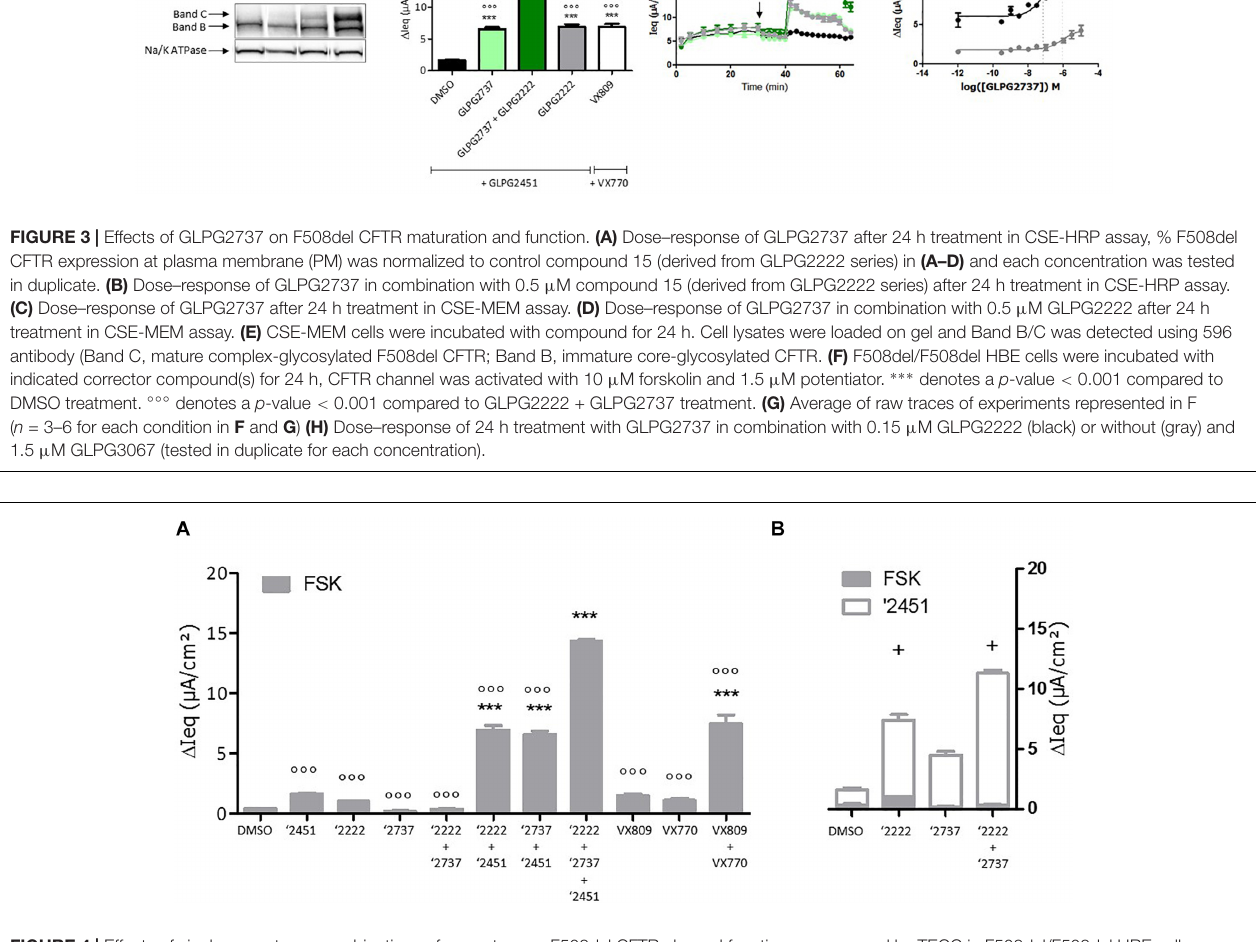
FIGURE 4 | Effects of single corrector or combinations of correctors on F508del CFTR channel function as measured by TECC in F508del/F508del HBE cells. (A) Compounds (0.15 µ M GLPG2222 and/or 1 µ M GLPG2737 and/or 1.5 µ M GLPG2451) were incubated on cells for 24 h, CFTR channel was activated with 10 µ M forskolin and change in short circuit current was measured in three to six replicates for each condition ∗∗∗ denotes a p -value < 0.001 compared to DMSO treatment. ◦◦◦ denotes a p -value < 0.001 compared to GLPG2222 + GLPG2737 + GLPG2451 treatment. (B) Compounds (0.15 µ M GLPG2222 and/or 1 µ M GLPG2737) were incubated on cells for 24 h, CFTR channel was activated with 10 µ M forskolin followed by 1.5 µ M potentiator GLPG2451 and change in short circuit current was measured after forskolin activation and after GLPG2451 addition. n = 3 for each condition and p -values are denoted with + meaning p < 0.01 comparing similar chronic conditions from panel (A) with acute potentiator conditions in panel (B)